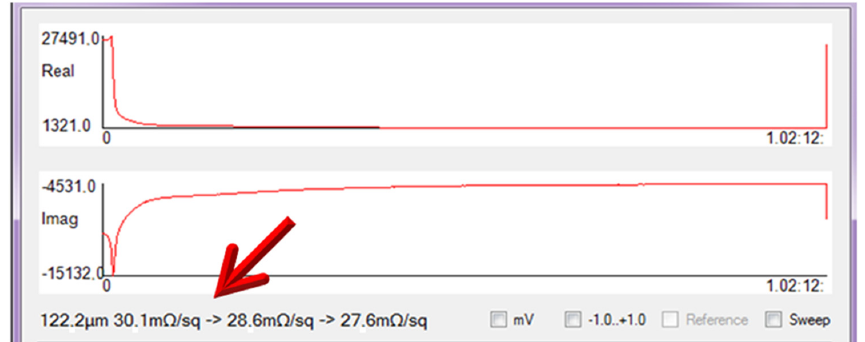
Figure 19. Screenshot of the Eddy Wet main menu illustrating prediction of the final parameter of particle based film.